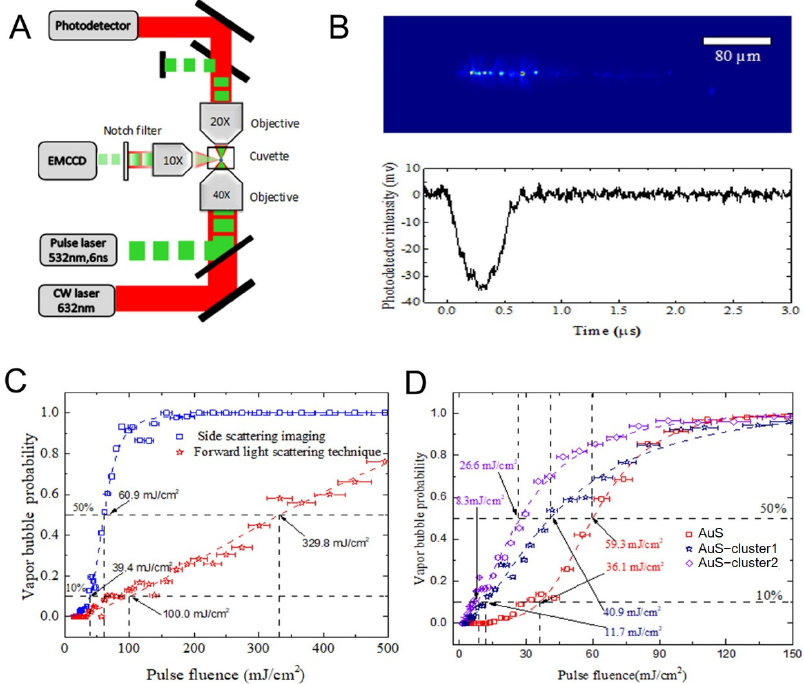
Figure 10. The fluence threshold measurement of pulsed laser induced vapor bubble mediated by PEG-AuS. Notes: ( A ) The schematic diagram of the experimental setup for vapor bubble measure- ment. ( B ) Side-scattering image of vapor bubble captured by camera (top) and the time response of